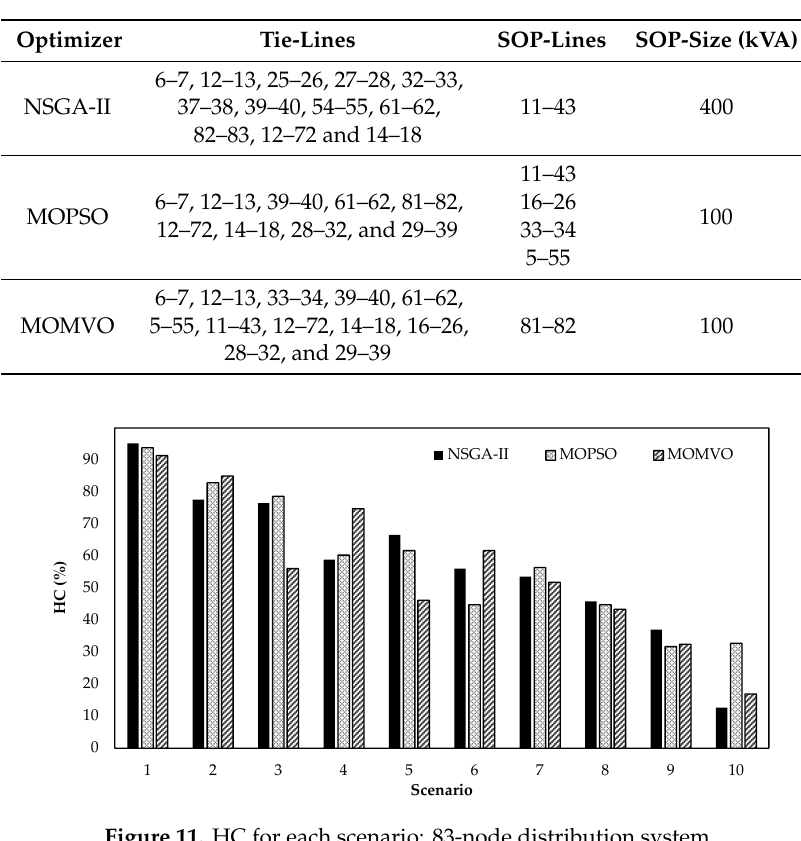
Table 12. Tie-lines, SOPs size, and locations.